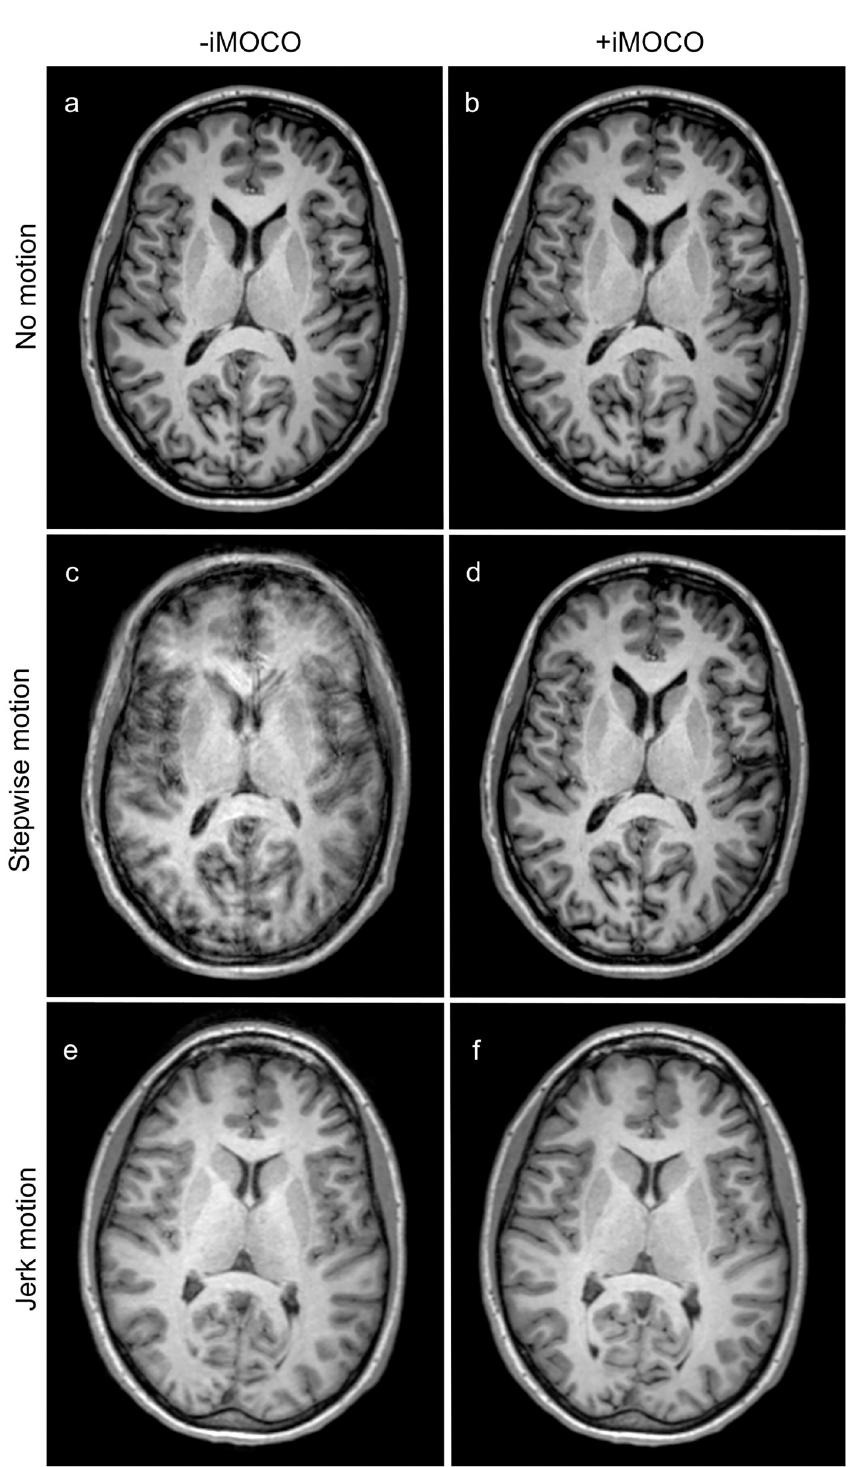
Fig 2. Examples of T1-weighted scans with (+) and without (-) iMOCO for different types of movement. Panels a – d are from subject 1, while panels e and f are from subject 5. The scans in a , b , d , and f were given a grading of 3 in all quality criteria. For the scans with motion -iMOCO, panel c was given a grading of 1 in all criteria, while panel e was given a grading of 2 in all regions except for the frontal horns, the septum pellucidum, and the anterior commissure and the columns of the fornix (not illustrated), where grade 3 was